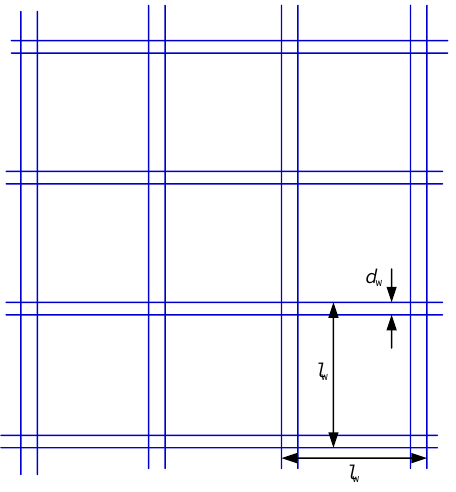
Figure 4. Illustration of net wine.